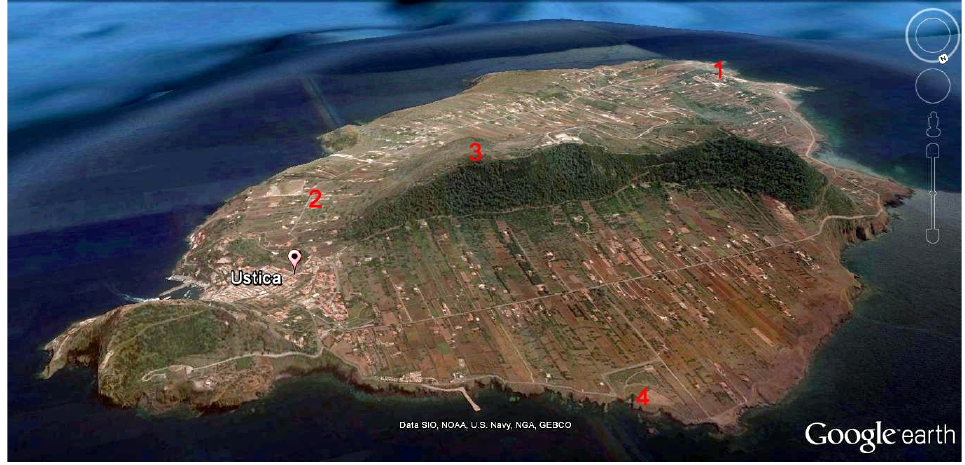
Figure 4 . Ustica main archaeological settlements: 1. Neolithic Pirozza (Spalmatore) Village; 2. Eneolithic Piano dei Cardoni Village; 3. Early Bronze Age Culunnella Village; 4. Middle Bronze Age Faraglioni Village (modified from Google